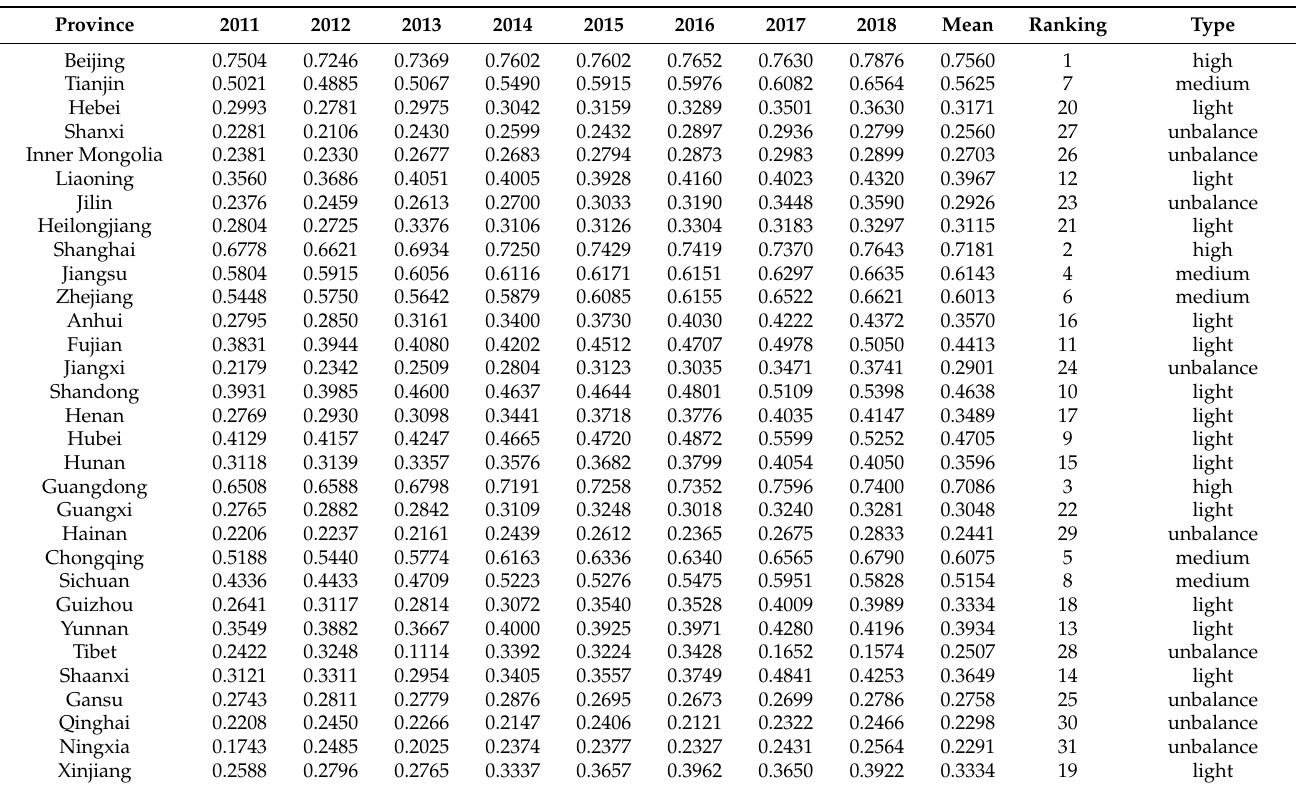
Table 5 calculated by the